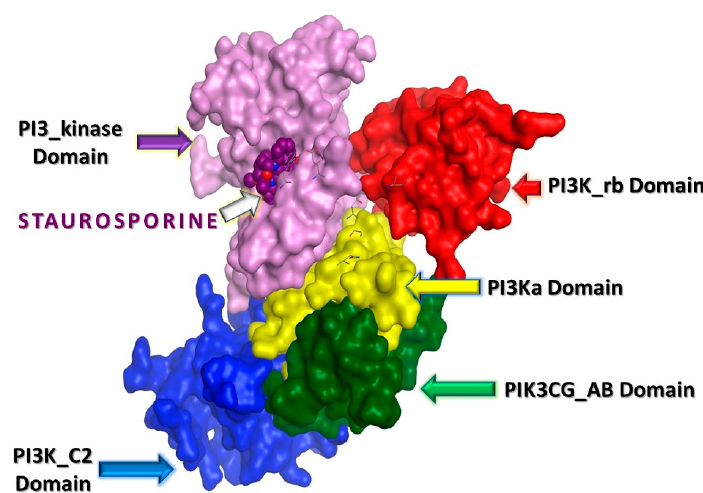
Figure 9. 3D structure of the PI3K protein wherein there is a PIK3 catalytic subunit gamma adap- tor-binding domain (green), 2. Ras-binding domain (red), 3. C2 domain (blue), 4. phosphoinositide 3-kinase family accessory domain (yellow), and 5. phosphoinositide 3/4-kinase domain (purple). Staurosporine is a PI3K inhibitor embedded in the phosphoinositide 3-kinase domain. AKT1 (RAC-alpha serine/threonine-protein kinase, Uniprot: P31749, Homo sapiens) is a member of the serine/threonine-protein kinases (AKT1, AKT2, and AKT3), called AKT kinases, which are all closely related. The phosphorylation of MAP3K5 (apoptosis- signal-related kinase) by AKT regulates cell viability. Downregulation by RNA interference results in the induction of caspase-dependent apoptosis. AKT1 consists of 480 amino acids, arranged with three main domains [62] (Figure 10A,B); Pleckstrin homology domain (amino acid residues 6-108, PH domain), protein kinase domain (amino acid residues 150-408, PKinase domain), and protein kinase C terminal domain (amino acid residues 429-474, Pkinase_C domain) [63] (Figure 11).